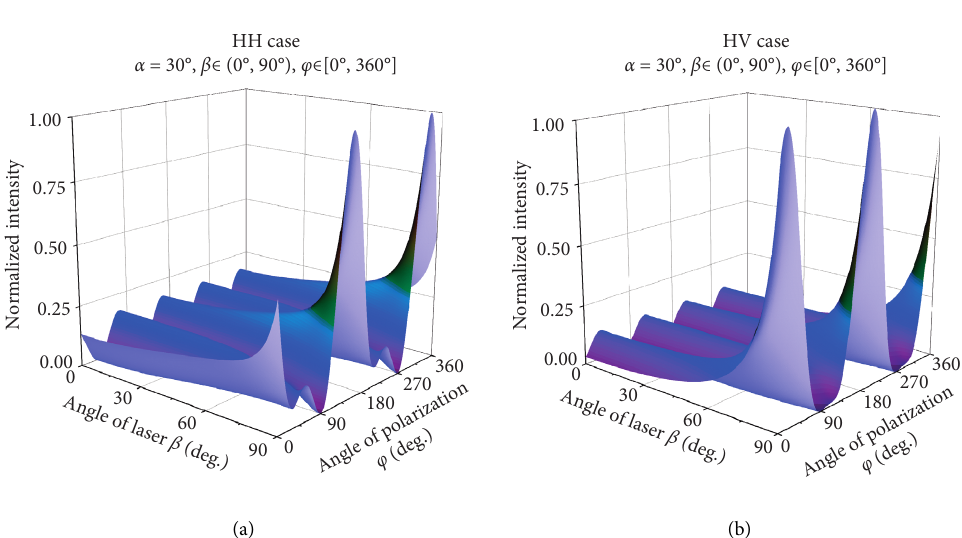
Figure 5: Raman intensity distribution under the oblique backscattering configuration for different inclination angles β and polarization directions φ when α � 30 ° in the (a) HH case and (b) HV case.